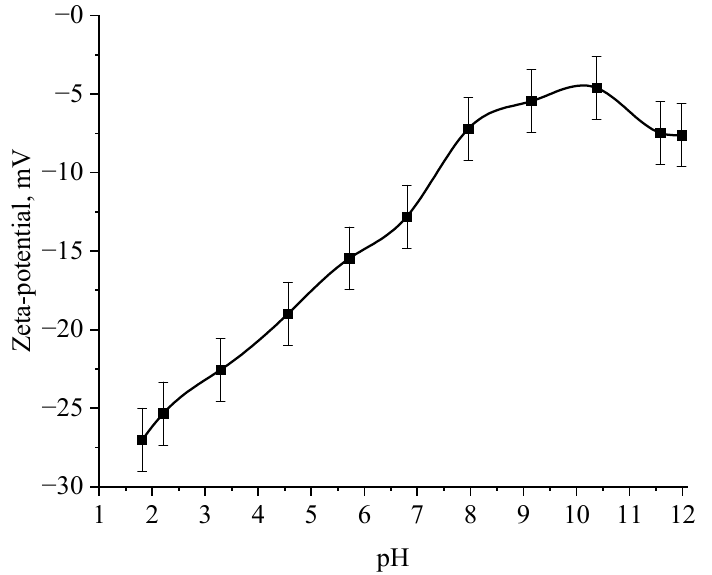
Figure 12. Dependence of the ζ -potential of Se NPs negative sol on the active acidity pH.